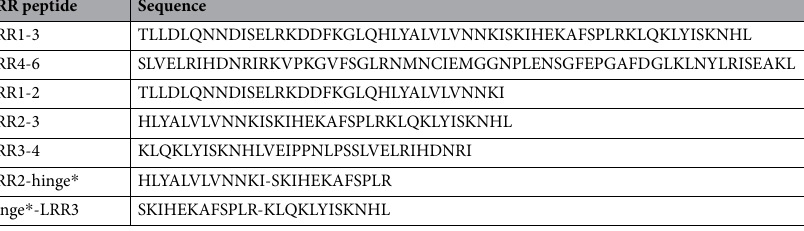
Table 1. Amino acid sequence of synthetic peptides for each core protein LRR. * Hinge: amino acid sequence between LRR2 and